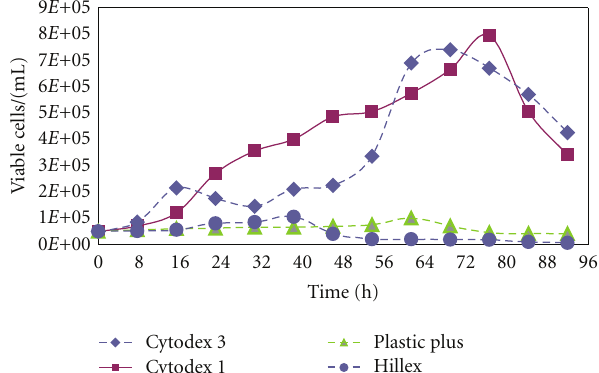
Figure 2: Comparison of Vero cell growth on di ff erent types of microcarrier in a 2L stirred tank bioreactor.